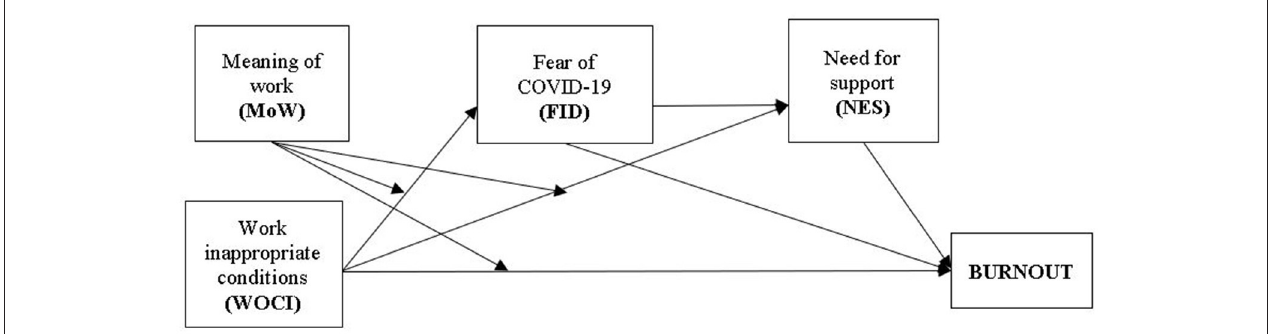
FIGURE 1 | The conceptual